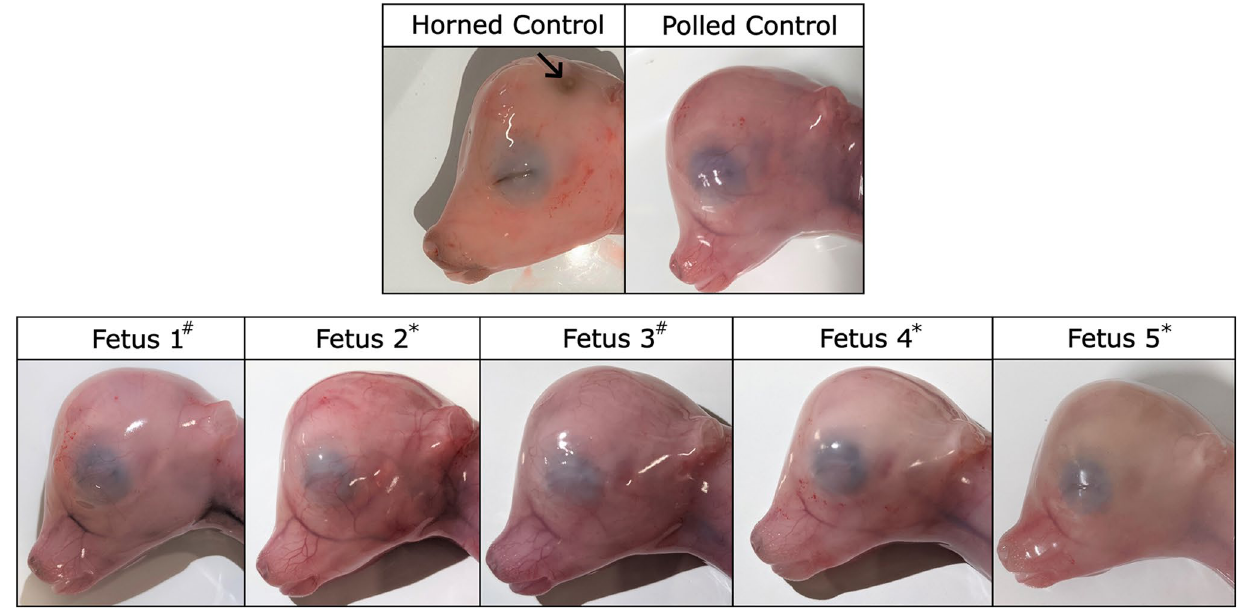
Figure 4. Phenotypic analysis of horn bud development in edited P C p fetuses and age-matched unedited horned (pp) and polled (P C p) controls. Fetuses were harvested at 90 days of gestation. Black arrow indicates cranial indent indicative of horn bud development. Edited fetuses were #mosaic or *biallelic lincRNA#1